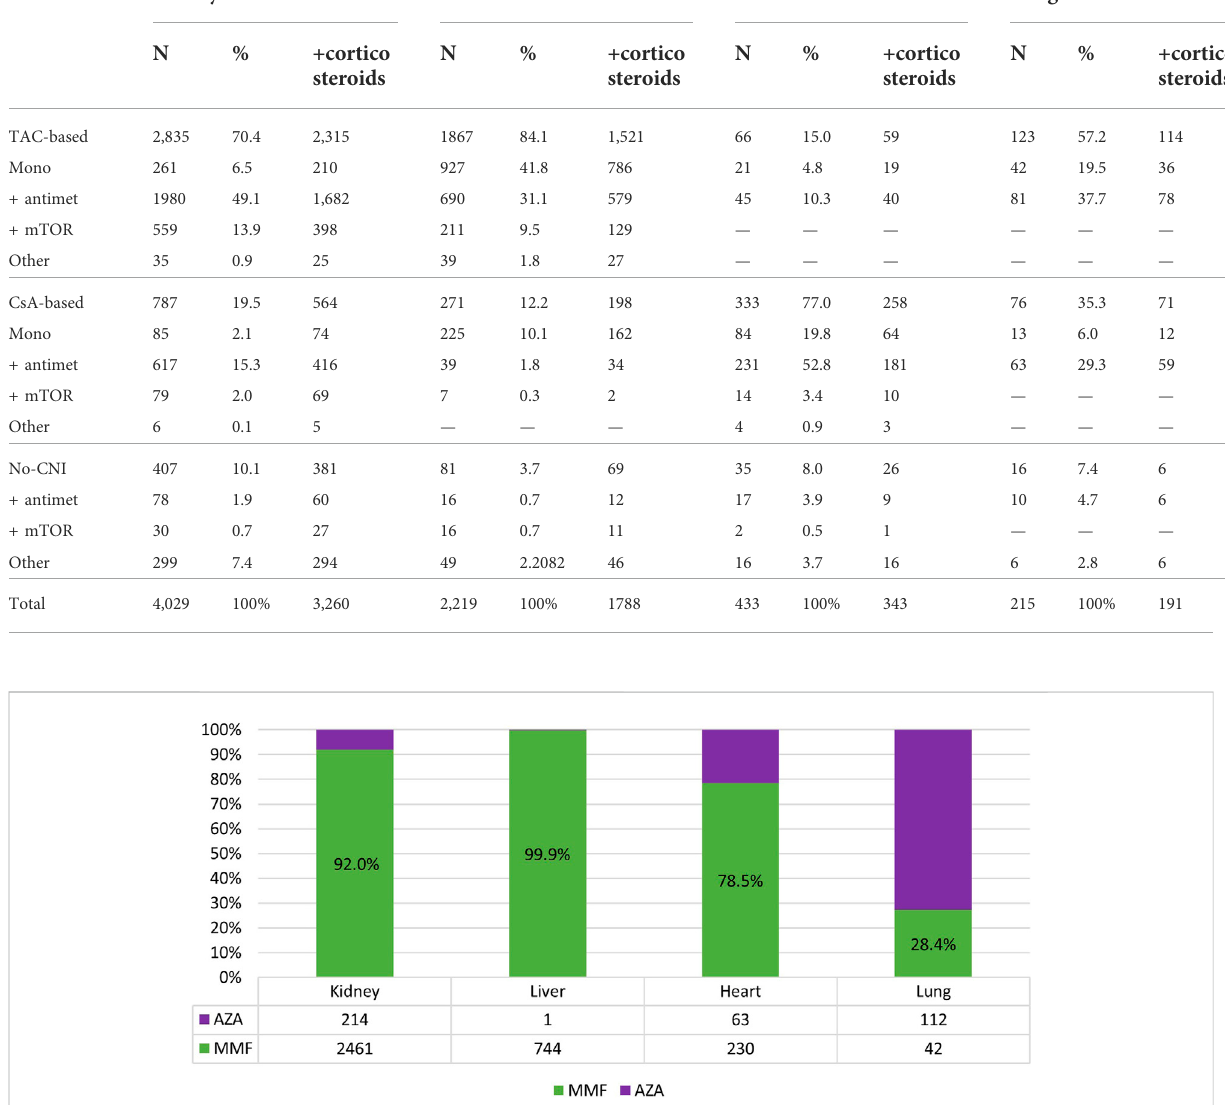
TABLE 2 Immunosuppressive maintenance therapy post-discharge by type of organ transplant. Kidney Liver